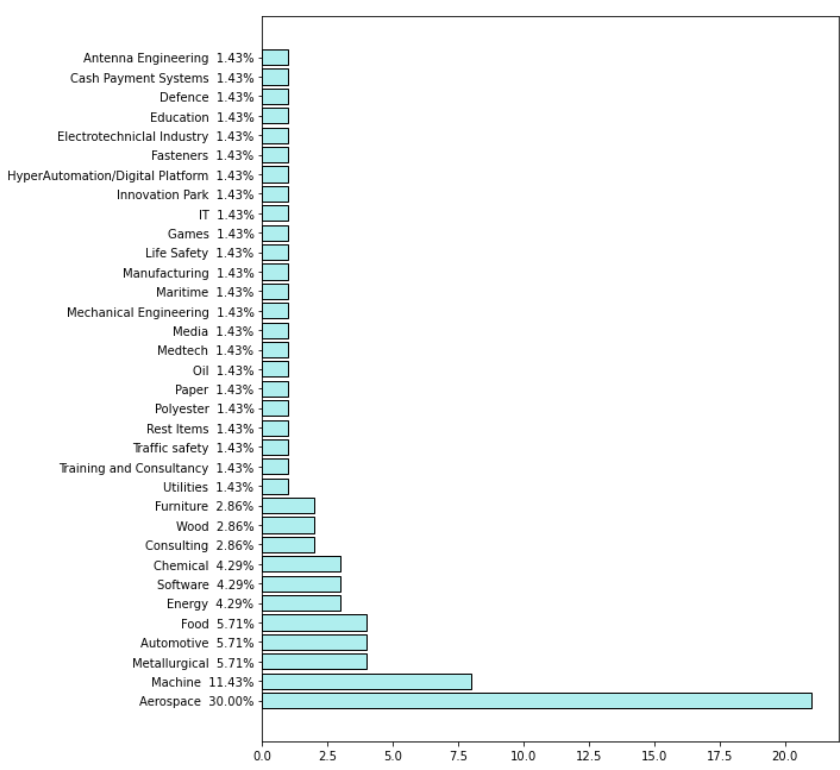
Figure 3. The percentage of questionnaires received from each industry.